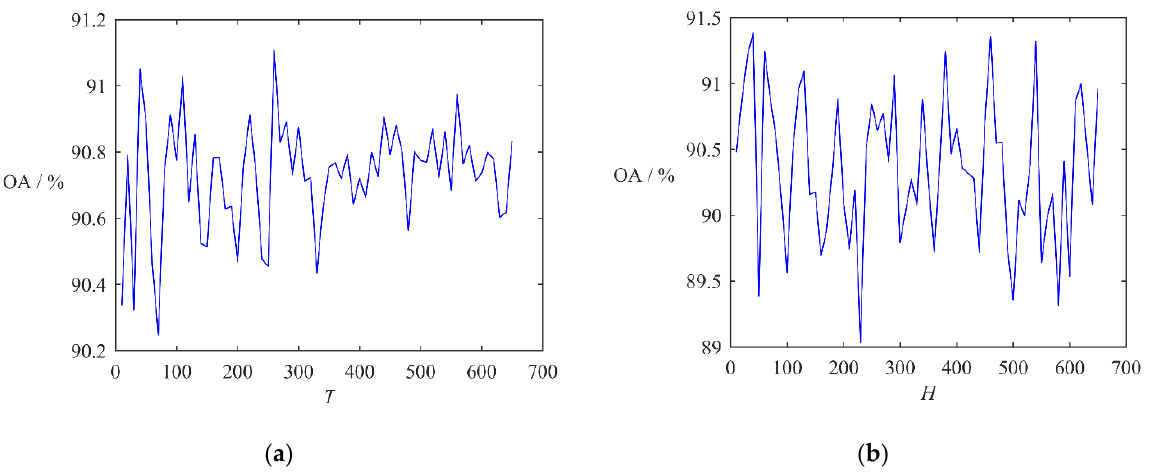
Figure 8. Analysis of the change of OA with the number of samplings T and the number of samples in each class H . ( a ) The change curve of T and OA. ( b ) The change curve of H and OA.